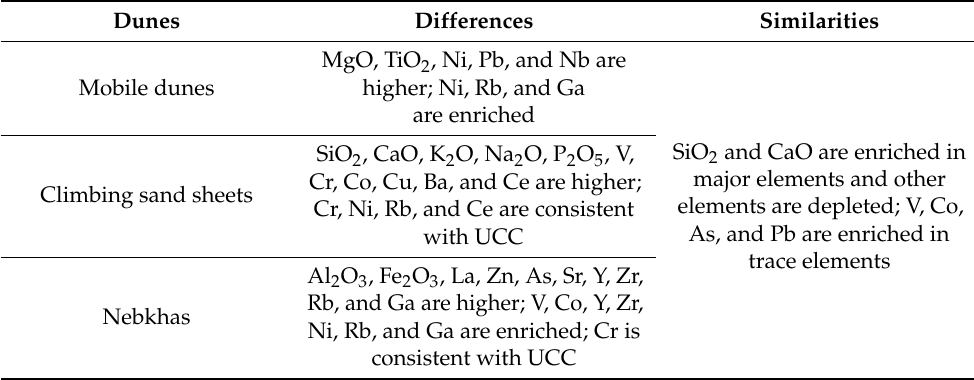
Table 3. Differences and similarities in the geochemical characteristics of different types of sand dunes. Dunes Differences Similarities MgO, TiO 2 , Ni, Pb, and Nb are Mobile dunes higher; Ni, Rb, and Ga are enriched SiO 2 and CaO are enriched in SiO 2 , CaO, K 2 O, Na 2 O, P 2 O 5 , V, major elements and other Cr, Co, Cu, Ba, and Ce are higher; sand sheets elements are depleted; V, Co, Cr, Ni, Rb, and Ce are consistent As, and Pb are enriched in with UCC trace Al 2 O 3 , Fe 2 O 3 , La, Zn, As, Sr, Y, Zr, Rb, and Ga are higher; V, Co, Y, Zr, Nebkhas Ni, Rb, and Ga are enriched; Cr is consistent with